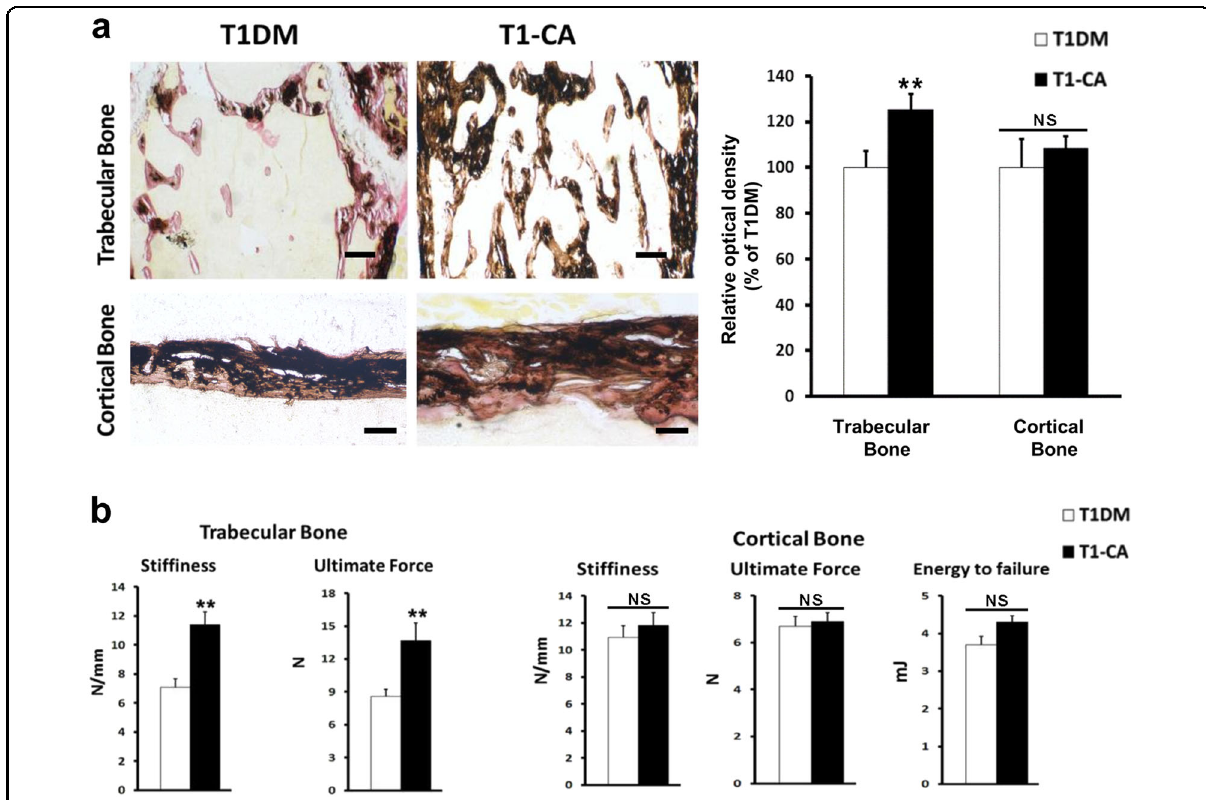
Fig. 5 Osteoblastic activation of β -catenin in T1DM mice improved bone strength to a greater extent in trabecular bone than in cortical bone. a Representative images of Von Kossa staining of femoral trabecular and cortical bone, with quantitative analysis on the right. n = 9. Scale bars, 50 μ m. b Mechanical strength of the femoral distal metaphysis and femoral diaphysis, as measured by a compression test and three-point bending test, respectively. n = 9. Data are expressed as the mean ± SD. ** P < 0.01 versus T1DM group by an unpaired t -test. NS not signi fi cant, P >